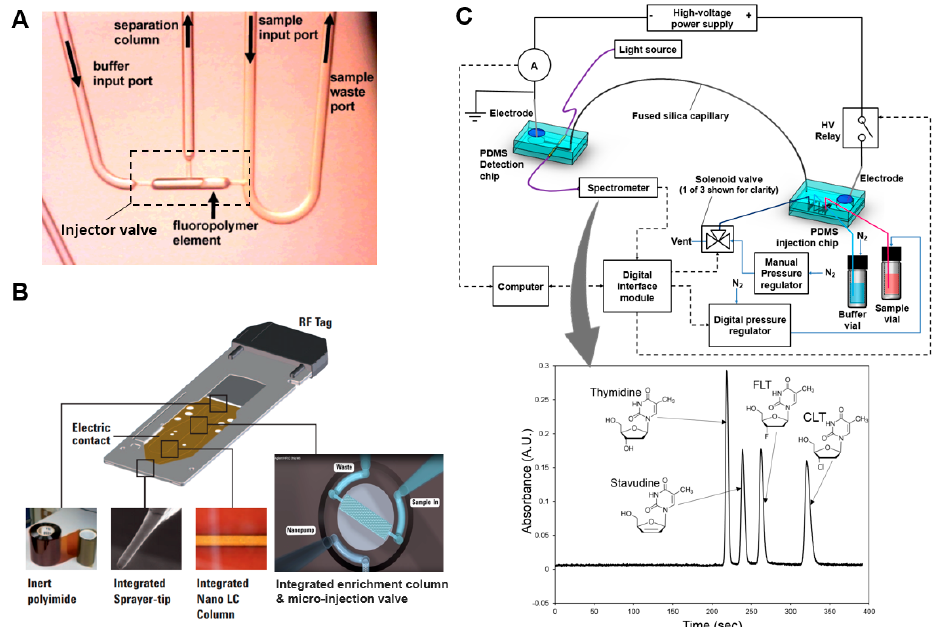
Figure 5. Examples of miniature chromatography systems. ( A ) Microfluidic HPLC system. A sliding